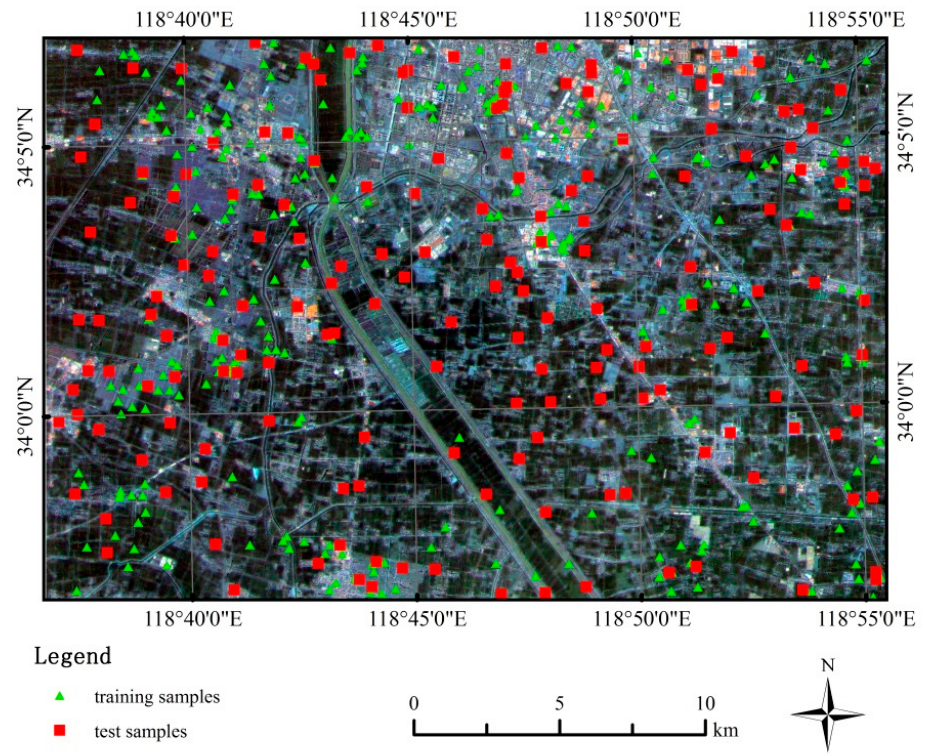
Figure 2. Training samples and test samples for object-oriented classification.